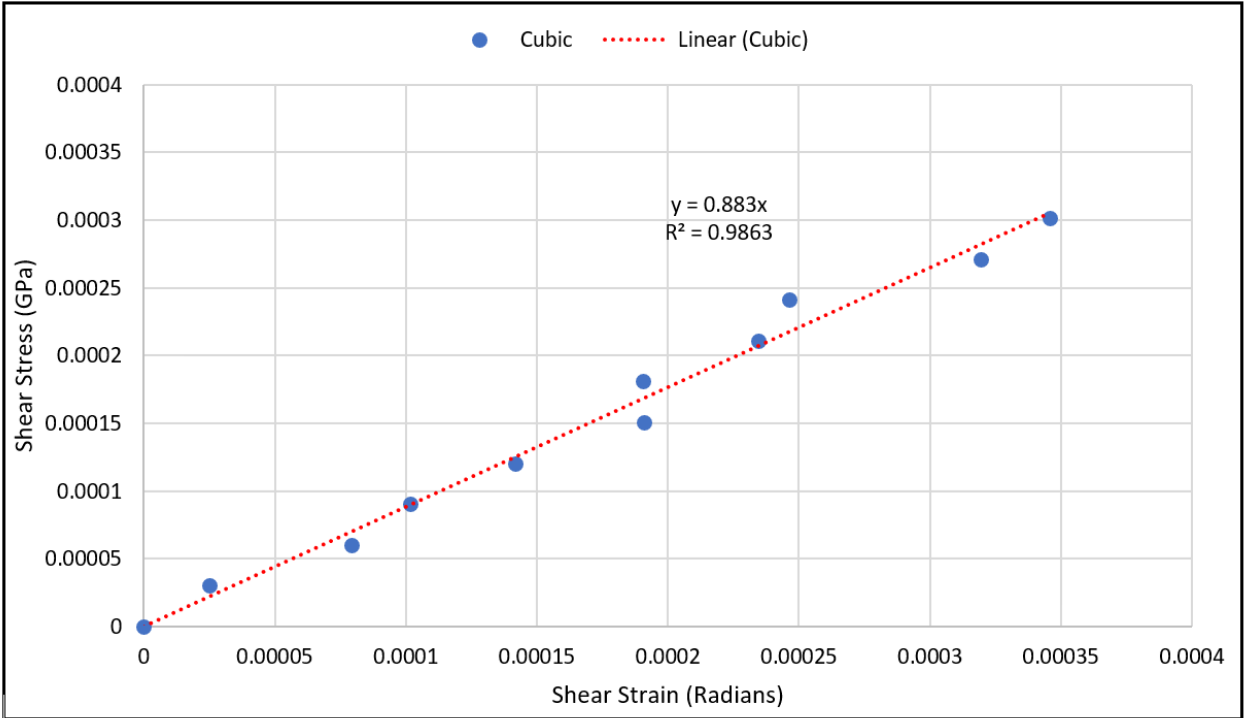
Figure 10. Shear stress vs. shear strain data points for the cubic scaffold.